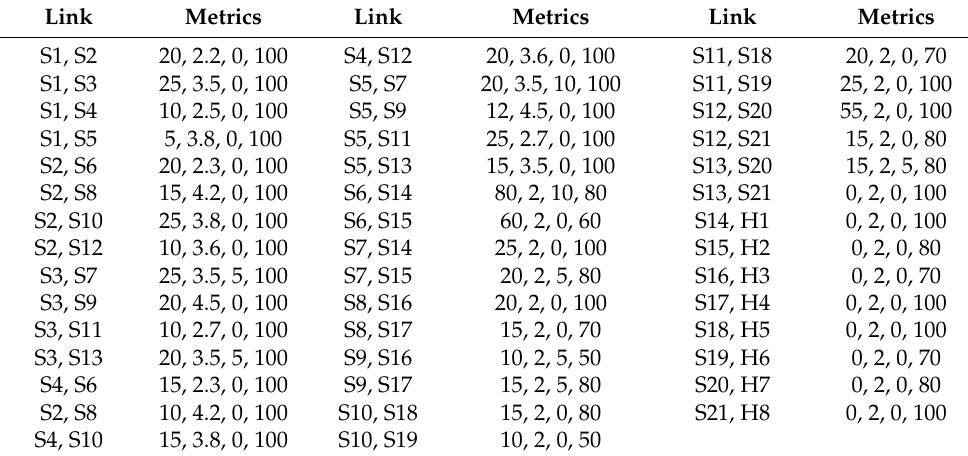
Table A1. Controller A Network Node metrics in the simulation model.